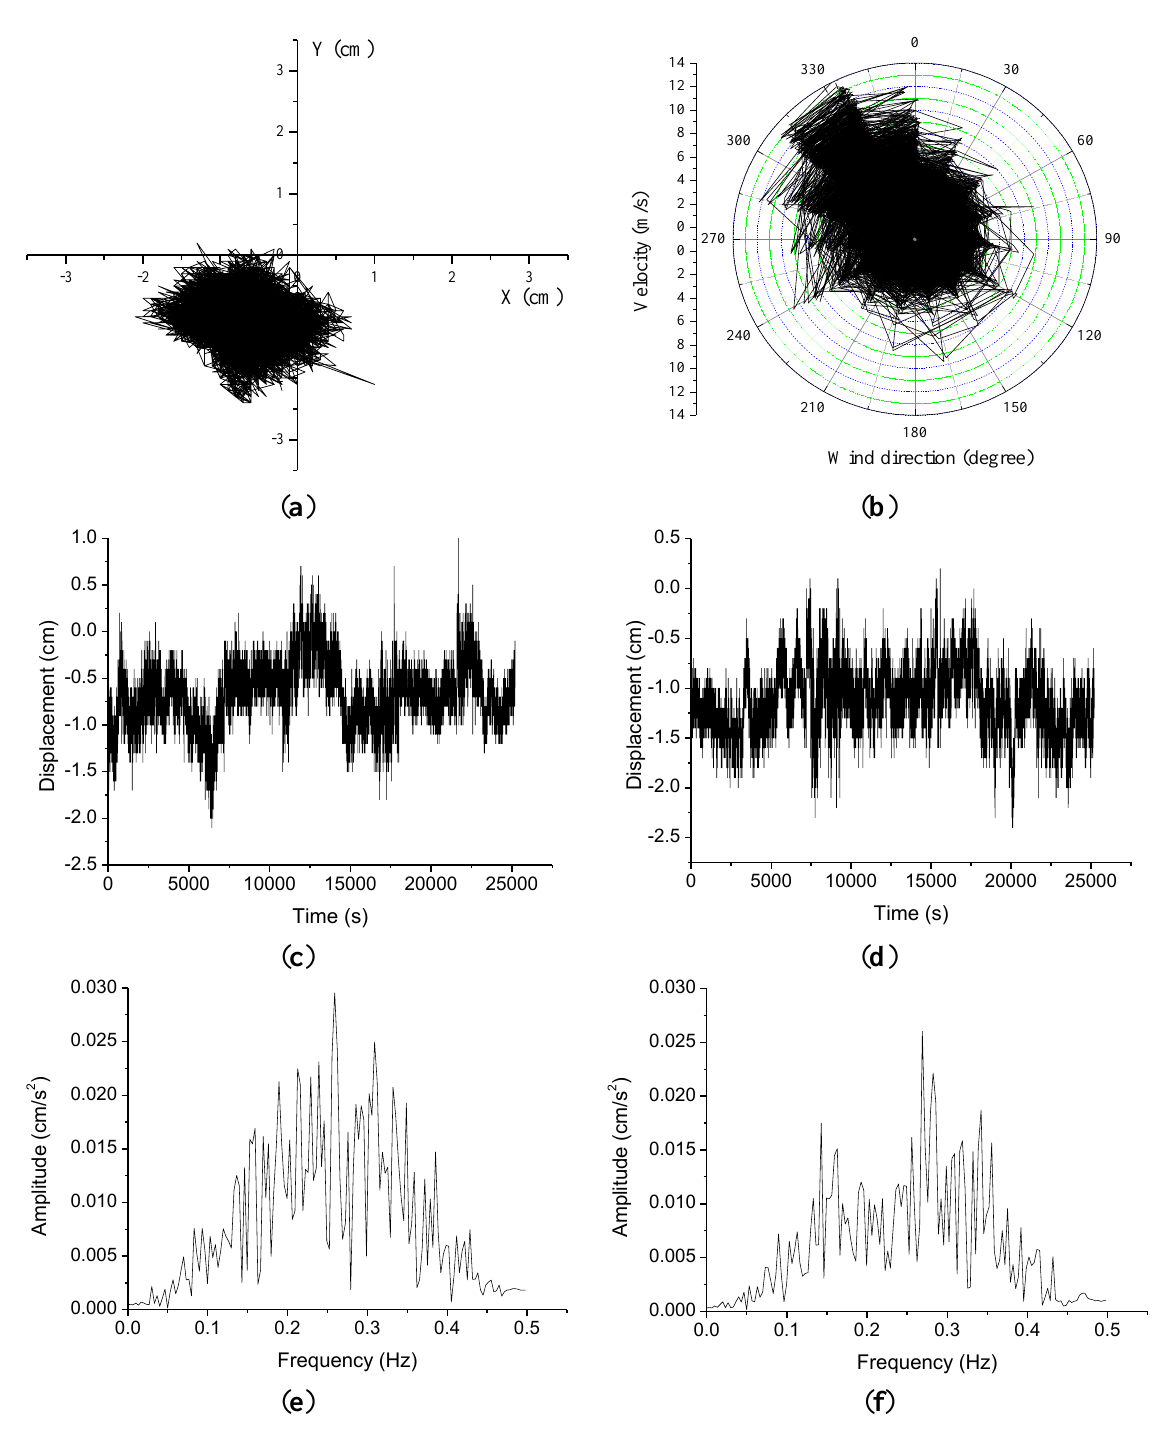
Figure 6. Displacement and wind speed after outrigger truss installation: ( a ) GPS displacement; ( b ) Wind speed and direction; ( c ) Time series in X-direction; ( d ) Time series in Y-direction. ( e ) Fourier spectrum in X-direction; ( f ) Fourier spectrum in Y-direction.